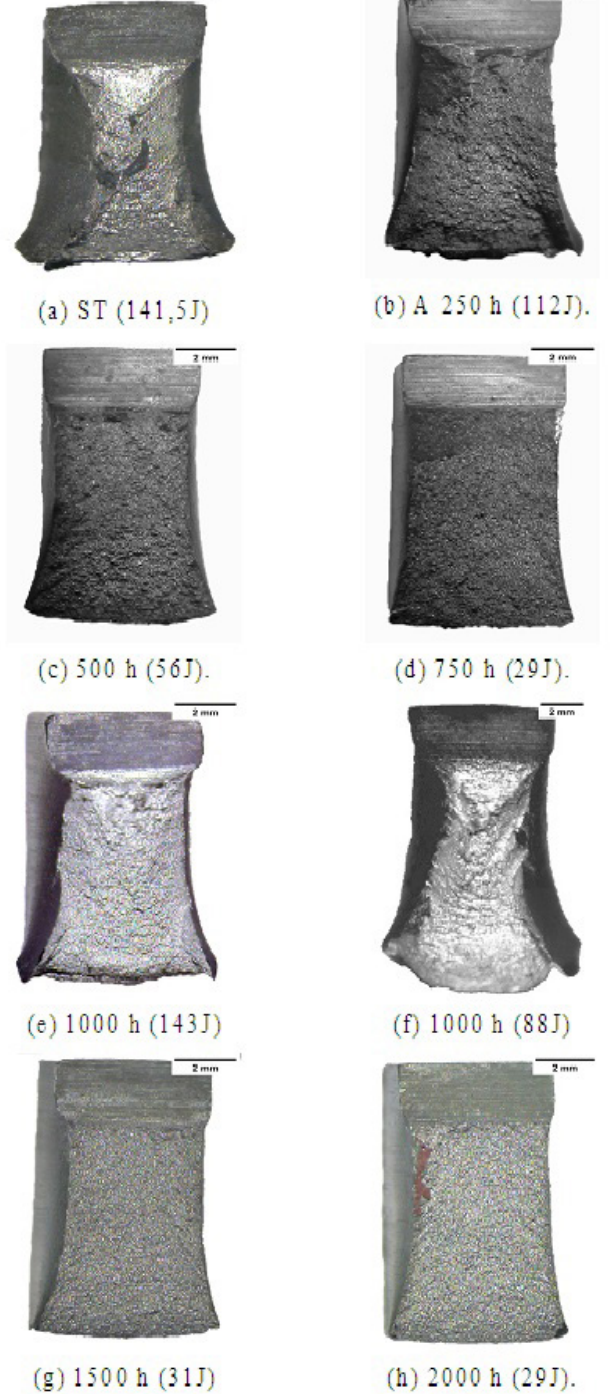
Figure 5. Fracture surface of Charpy specimen´s performed: (a) ST (b) 250 h, (c) 500 h, (d) 750 h, (e and f) 1000 h, (g) 1500 h and (h) 2000